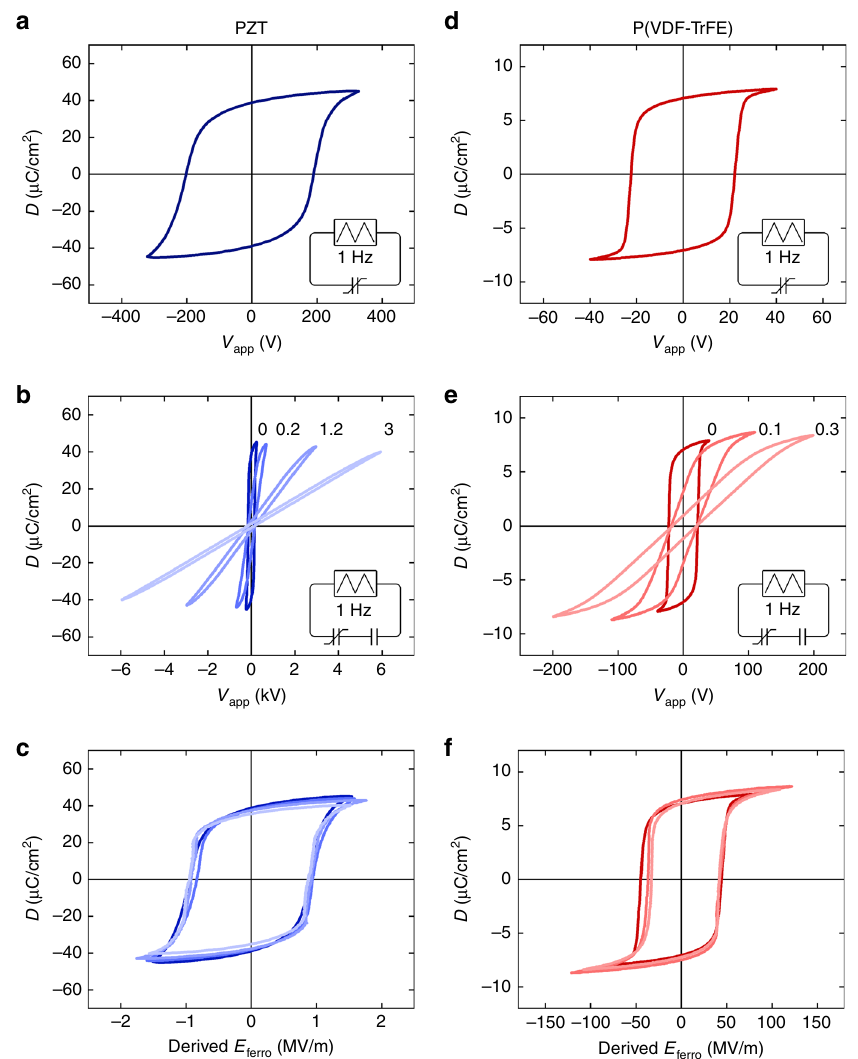
Fig. 1 Quasi-static hysteresis loops. a , d Electric displacement vs. applied voltage measured quasi-statically at 1 Hz on a ceramic Pb(Zr, Ti)O 3 (PZT) and poly(vinylidene fl uoride – tri fl uoroethylene) [P(VDF – TrFE)] ferroelectric-only capacitor, respectively. The insets schematically show the measurement circuit. b , e Electric displacement vs. applied voltage measured at 1 Hz on a PZT and P(VDF – TrFE) ferroelectric capacitor in series with different linear capacitors. The ratio of capacitances varies from 0 to 3 for PZT and from 0 to 0.3 for P(VDF – TrFE), and is indicated. At high bias the displacement is the same as for the ferroelectric-only capacitor. For larger ratios of C ferro / C ser , a higher applied voltage is needed to fully polarize the ferroelectric capacitor. c , f Reconstructed loops as a function of the electric fi eld inside the ferroelectric material, E ferro , which is derived by classical electrostatics as described in the section “ Methods ” . The reconstructed loops for various C ferro / C ser ratios are similar to that of the ferroelectric-only